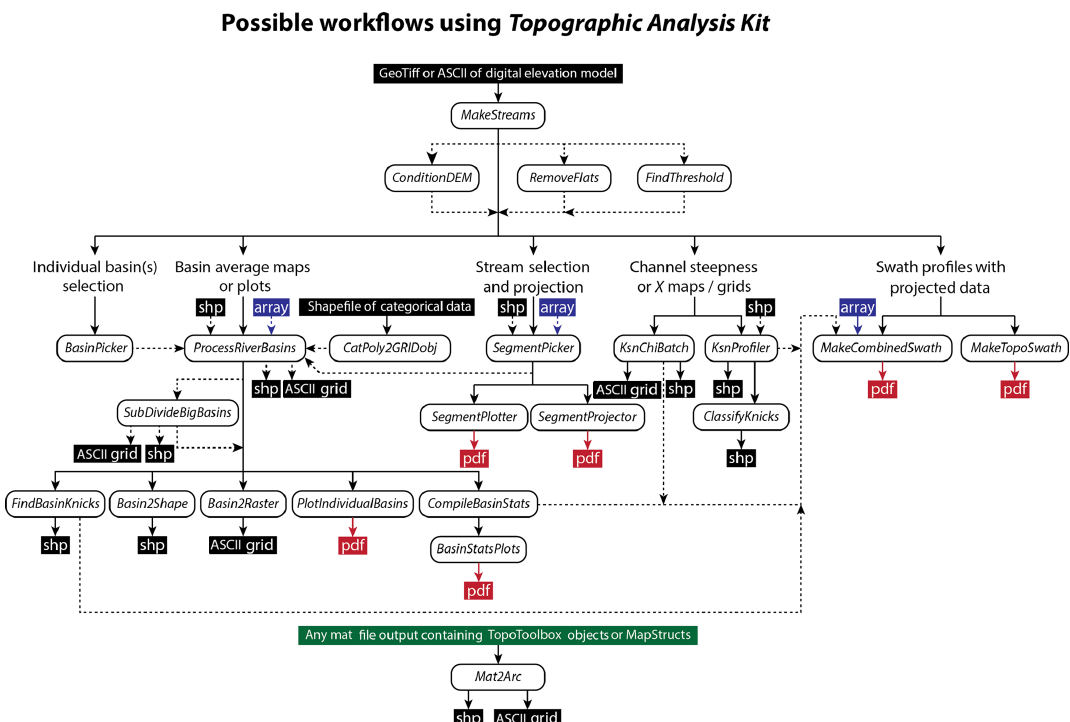
Figure 1. Suggested workflows through TAK functions depending on desired outcome and purpose of analysis. Also highlighted are the nature of the outputs produced by different functions. Definitions of inputs and outputs: shp – a shapefile containing vector data, the geometry of which (e.g., points, lines, polygons) depends on the tool in question; array – a MATLAB array, i.e., a matrix of numbers; ASCII grid – an ESRI ASCII text file that is interpretable as gridded raster data with projection information by many geographic information systems (GIS) programs; pdf – a figure output in Portable Document